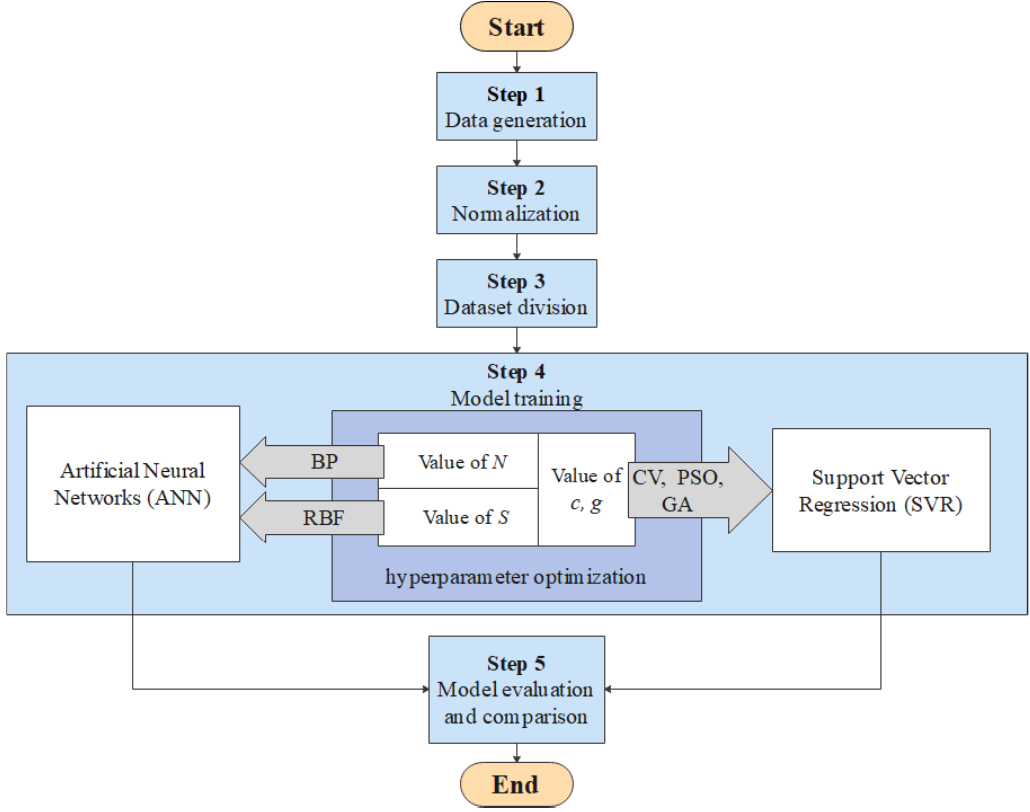
Figure 10. Flow chart of the machine learning methodology.